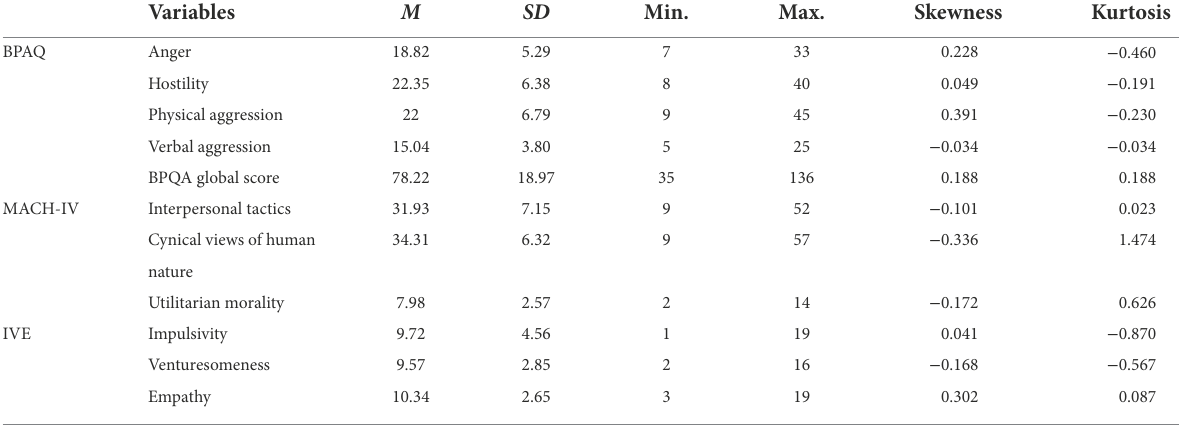
TABLE 3 Descriptive statistics for BPAQ, MACH-IV, and IVE for prisoners